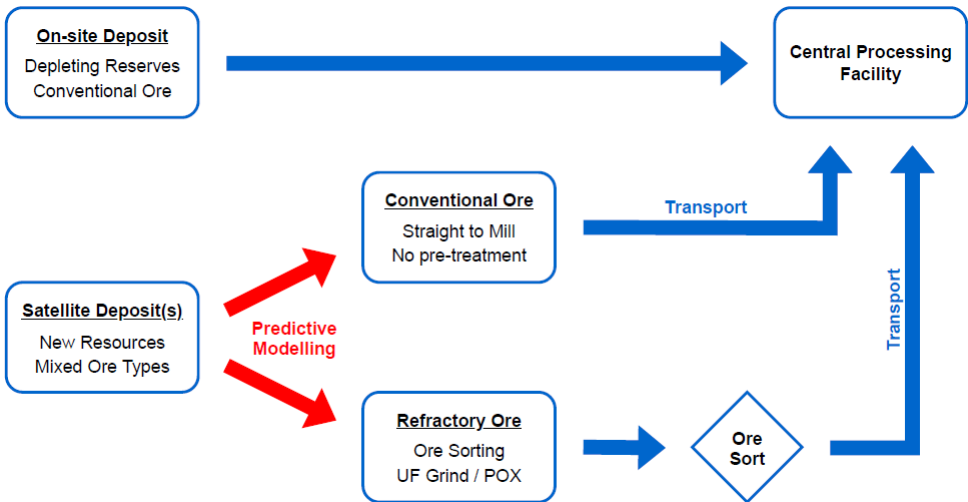
Figure 2. Schematic flow chart showing the developed regionalized framework strategy for han- dling conventional and refractory gold ore sources at a central processing facility. Abbreviations: UF = ultrafine, POX = pressure oxidation.